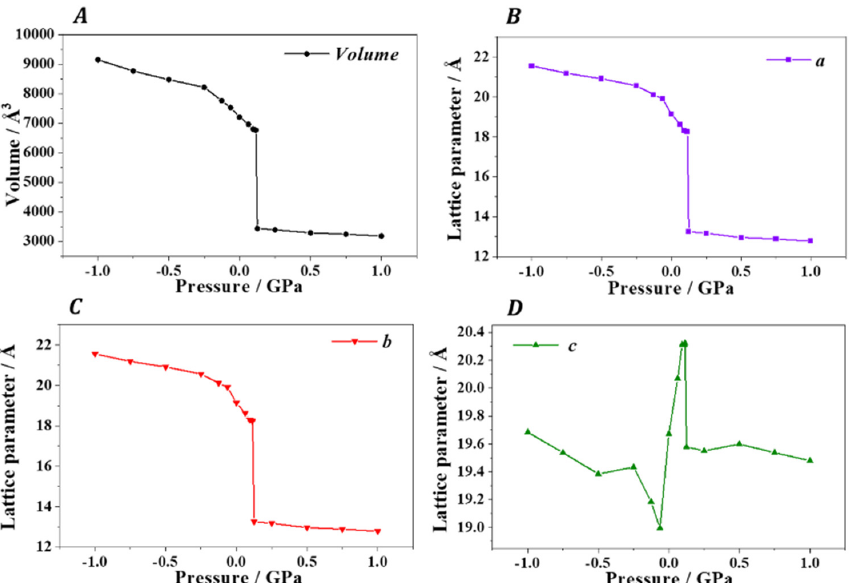
Figure 4. Computed unit cell volumes and lattice parameters of ZIF-75 as a function of the applied isotropic pressure: ( A ) unit cell volume; ( B ) a lattice parameter; ( C ) b lattice parameter; ( D ) c lattice parameter.